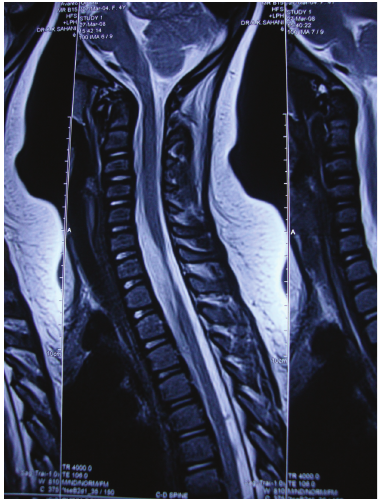
Figure 1: MRI of spine showing injury from C7 to